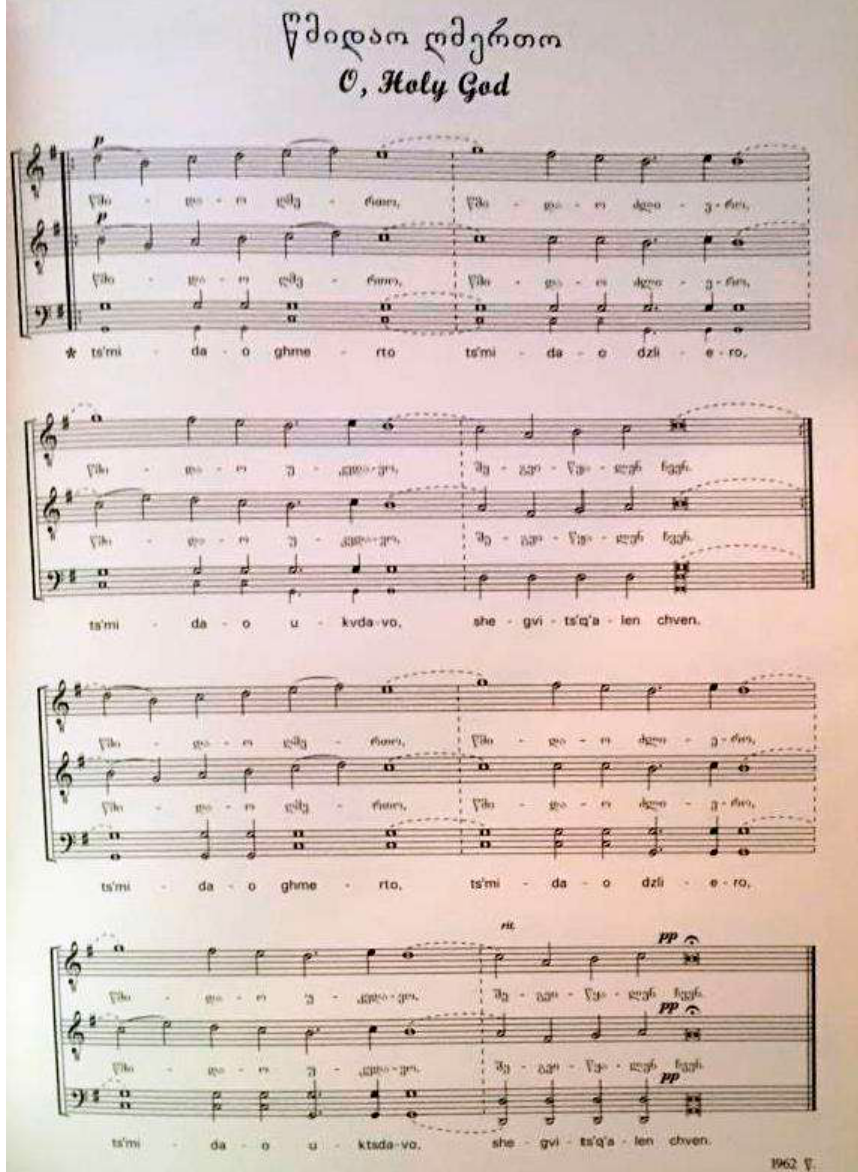
Figure 12. Trisagion; composed by Patriarch Ilia II (Jangulashvili 2013).